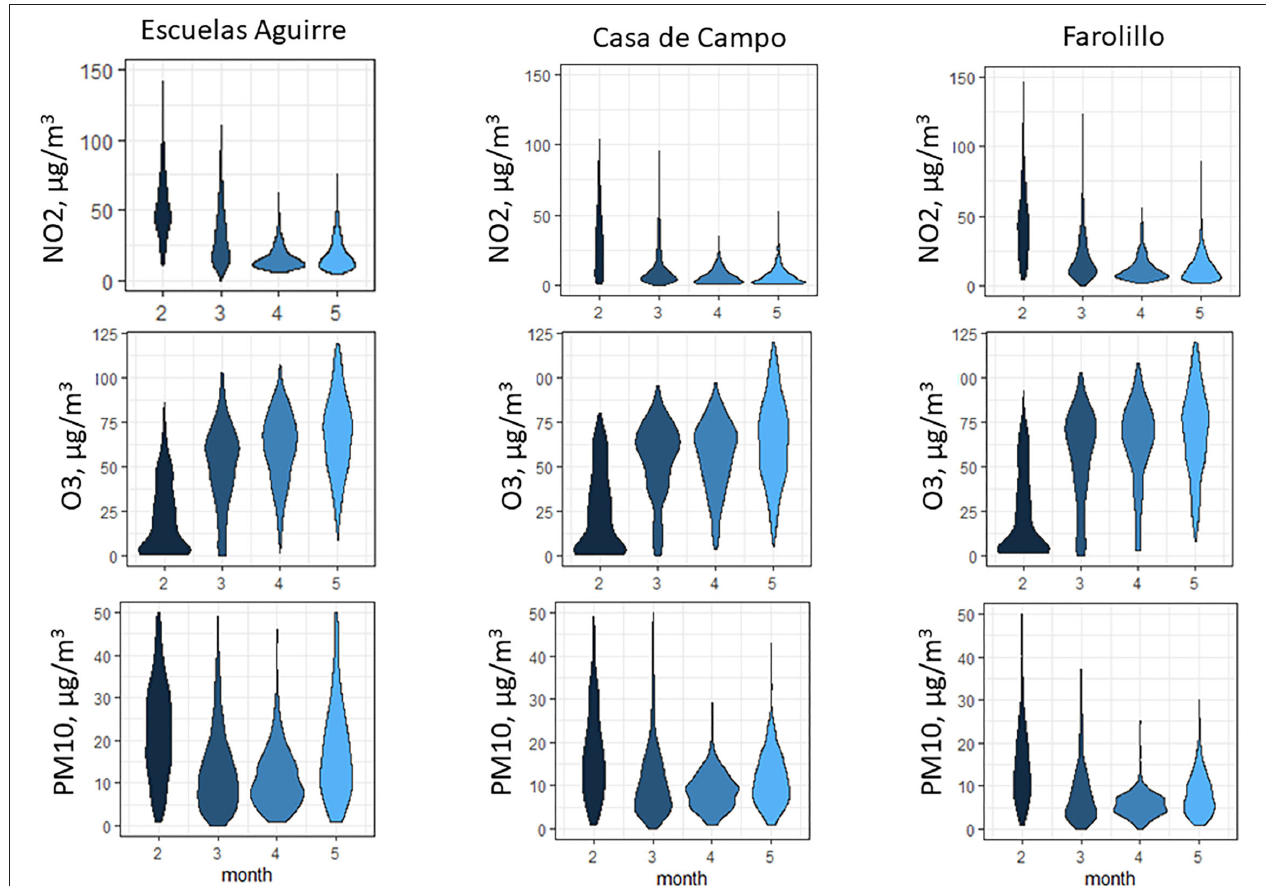
FIGURE 4 | The violin plots for the three air quality stations (AQSs) and the pollutants NO 2 , O 3 , and PM 10 grouped by consecutive months in (2020). were similar to those in February when no measures were